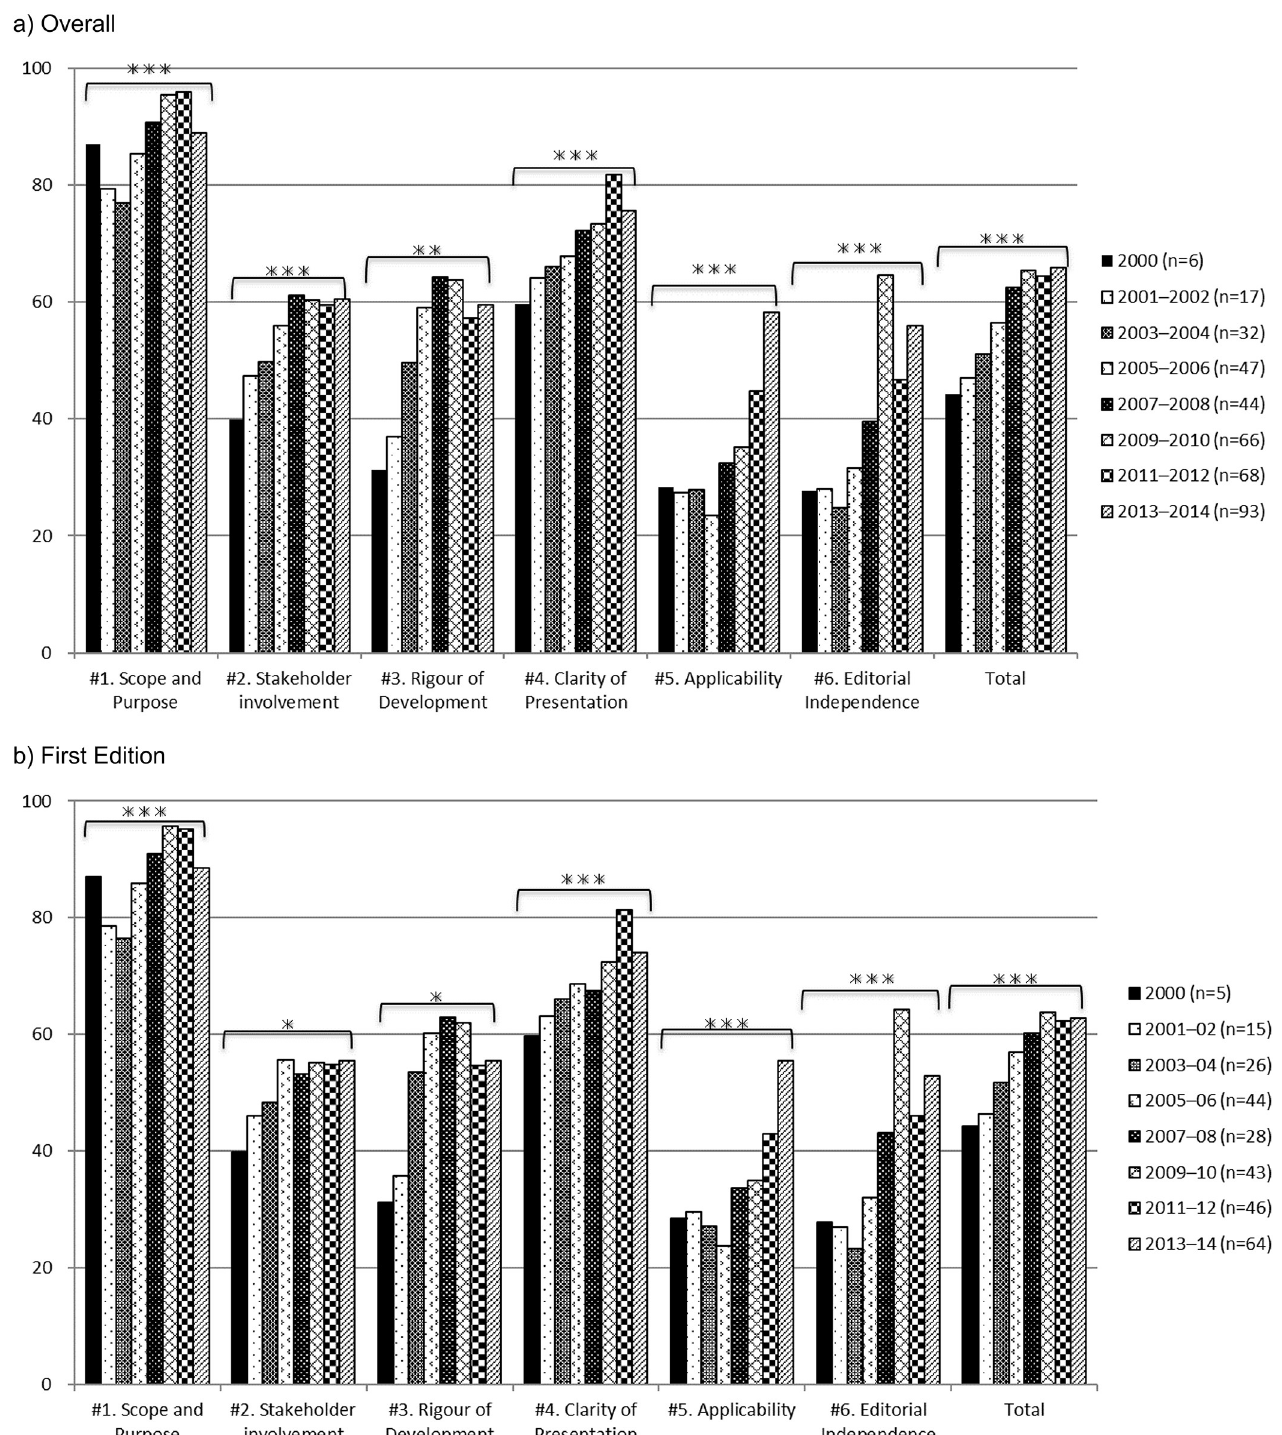
Fig 1. Time trend analysis of median scores of clinical practice guidelines. Test: Kruskal-Wallis test, � p < 0.05, �� p < 0.01, ��� p < 0.001.